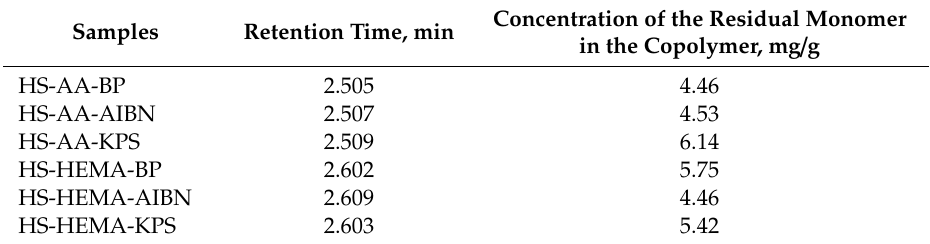
Table 3. The amount of the retained monomer in the copolymer after grafting.